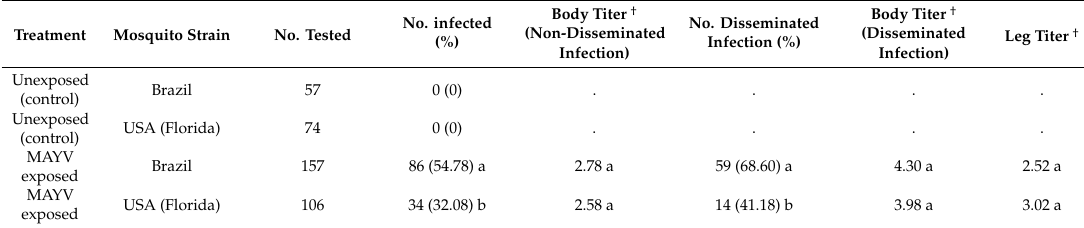
Table 2. Mayaro virus (MAYV) infection and viral titer in Brazilian and Florida populations of Aedes aegypti . Viral titers are expressed in log 10 plaque forming unit equivalents / mL. Mosquitoes were tested for infection on the day they died following ingestion of MAYV-infected